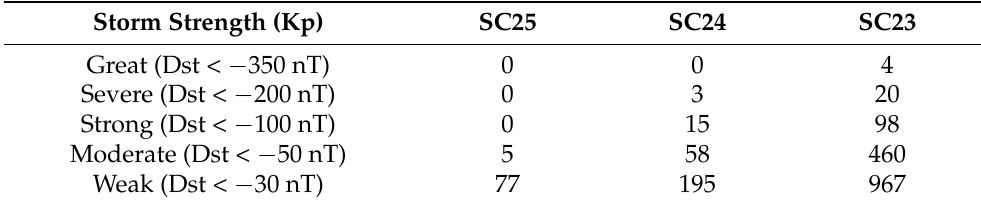
Table 2. Geomagnetic storms classification based on the Dst index. Storm Strength (Kp) SC25